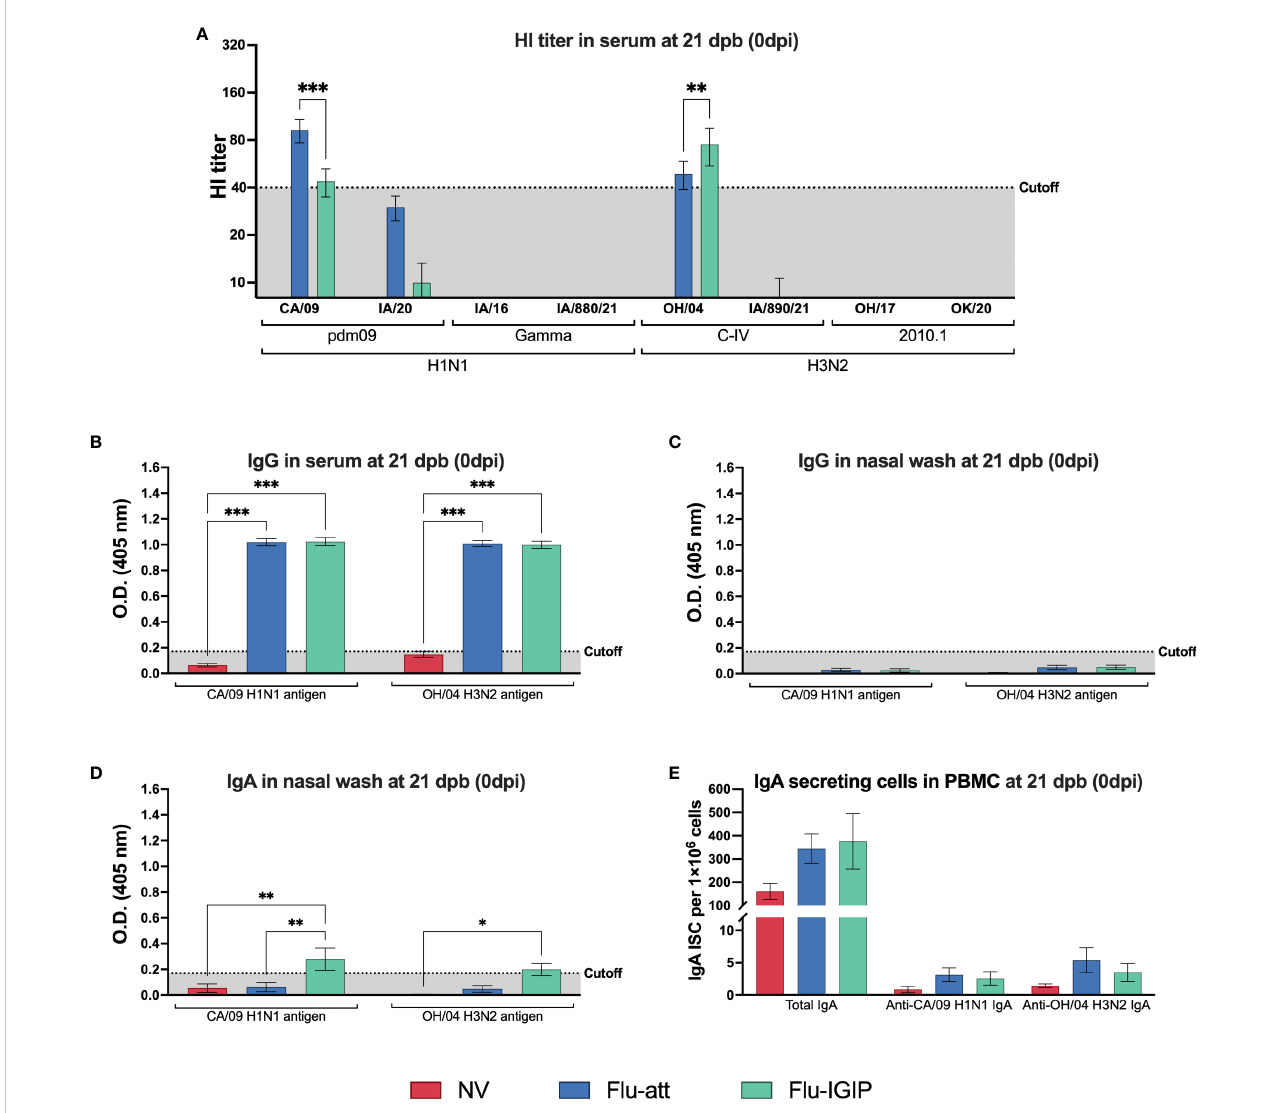
FIGURE 1 In fl uenza-speci fi c immune response prior to inoculation. Pigs were not vaccinated (NV, red bars) or vaccinated with bivalent Flu- att (blue bars) or Flu- IGIP (green bars) containing CA/09 H1N1 and OH/04 H3N2 viruses. Hemagglutination inhibition titers were measured (A) 21 days post-boost (dpb). IgG levels in sera (B) and nasal wash (C) , and IgA levels in nasal wash (D) were measured by ELISA at 21 dpb. Number of IgA secreting B cells (ISC) in peripheral blood mononuclear cells (PBMC) following B cell stimulation was determined by ELISPOT for total and in fl uenza-speci fi c IgA (E) . Viruses on the x-axis represent antigens used in each assay: CA/09, A/California/04/09 (H1N1pdm09); IA/20, A/swine/Iowa/A02524480/2020 (1A.3.3.2 H1N1pdm09); IA/16, A/swine/Iowa/A01778877/2016 (1A.3.3.3 gamma H1N1); IA/880/21, A/swine/Iowa/A02245880/2021 (1A.3.3.3 gamma H1N1); OH/04, A/turkey/Ohio/313053/2004 (H3N2 C-IV); IA/890/21, A/swine/Iowa/A02635890/2021 (H3N2 C-IVA); OH/17, A/swine/Ohio/A01354299/2017 (H3N2 2010.1); and OK/20, A/swine/Oklahoma/A02479048/2020 (2010.1 H3N2). Results displayed as means ± standard error of the mean. Dotted shaded areas indicate assay cutoff values known to be protective for HI assays or calculated as the average of negative pigs + 3 times the standard error of the mean for ELISA assays. *p ≤ 0.05; **p ≤ 0.01; ***p ≤